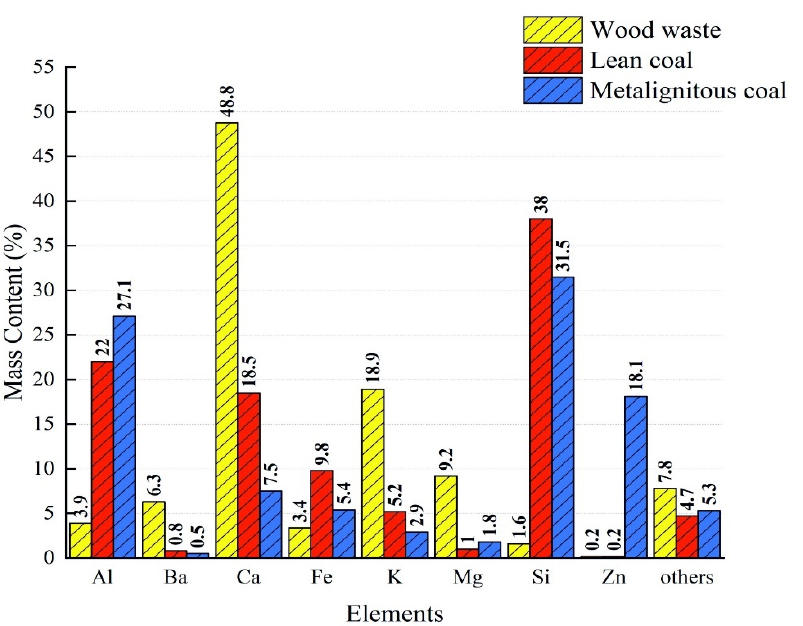
Figure 10. Ultimate elemental composition of the ash of the studied wood waste, lean coal, and metalignitous coal.